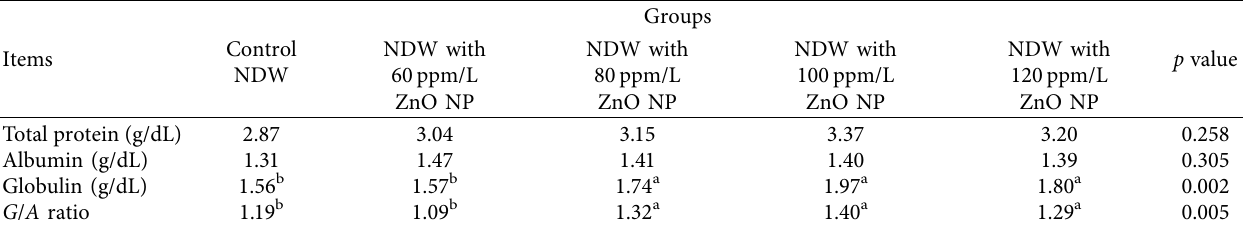
Table 3: Efect of zinc oxide nanoparticles (ZnO NPs) on total protein, albumin, globulin, and globulin to albumin ratio (%) at 35 days of